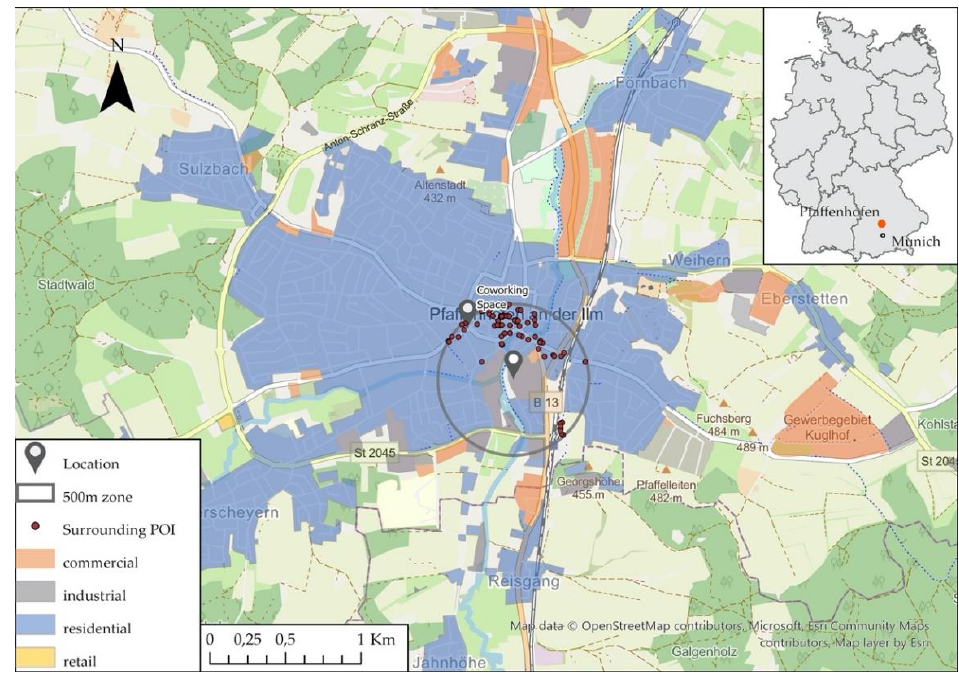
Figure 14. Map of all POIs of the category ’pois_free’ in Pfaffenhofen an der Ilm, Georg -Hipp-Straße (without scale) source: ArcGIS ® software by Esri, OSM, gefabrik.de, coworkingmap.de, © GeoBasis-DE/BKG (2020).